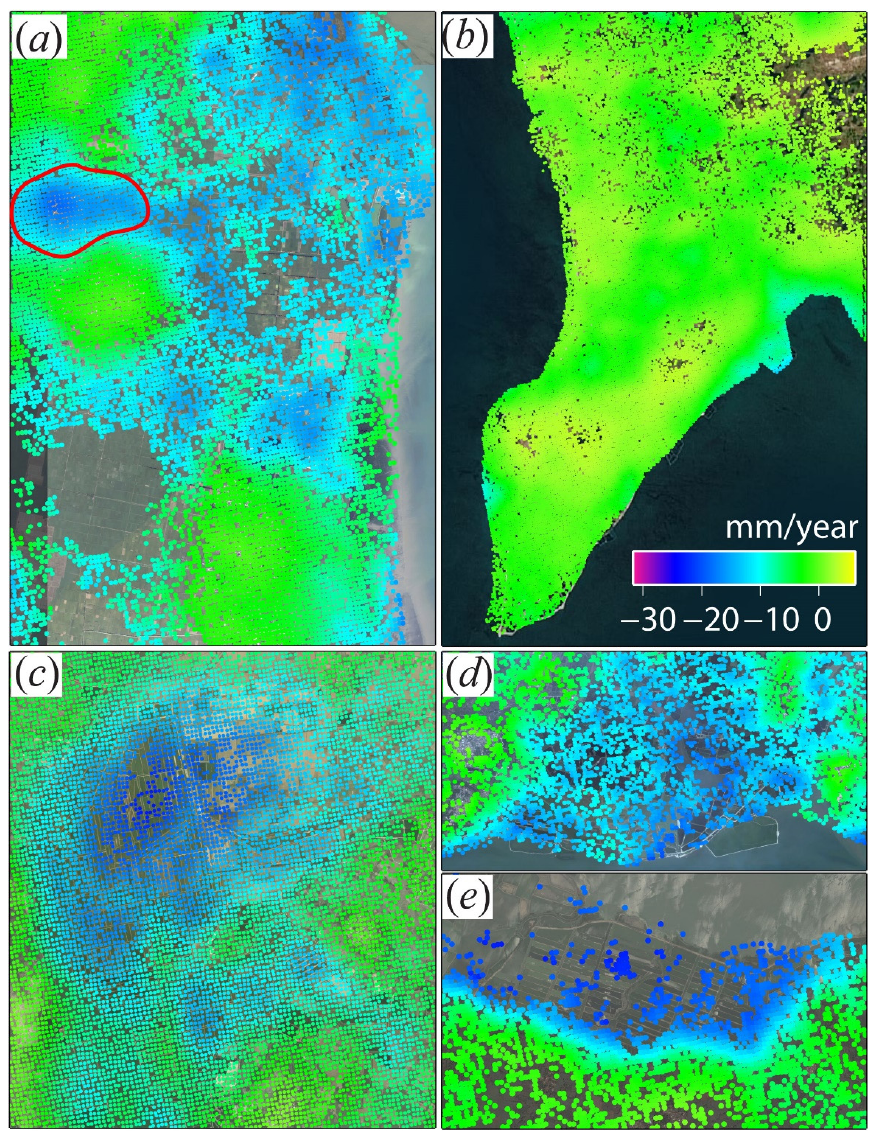
Figure 10. Average deformation rate of the five representative coastal areas for ALOS1 dataset from December 2006 to July 2010. ( a )–( e ) are enlarged views of the red rectangles in Figure 4c. ( a ) is an area covered with large ‐ scale farmlands, the maximum subsidence rate is 18 mm/year; ( b ) is located at the south of LZP with a maximum subsidence rate of 13 mm/year and a uplift rate of 3 mm/year; ( c – e ) are areas with large ‐ scale aquaculture, the maximum subsidence rates are 23, 20, and 23 mm/year, respectively.